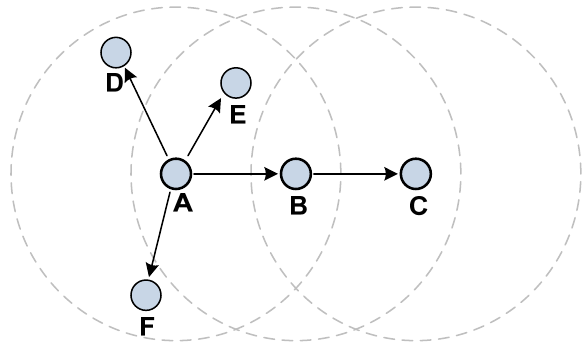
Figure 13. IBC-HWMP detection method.